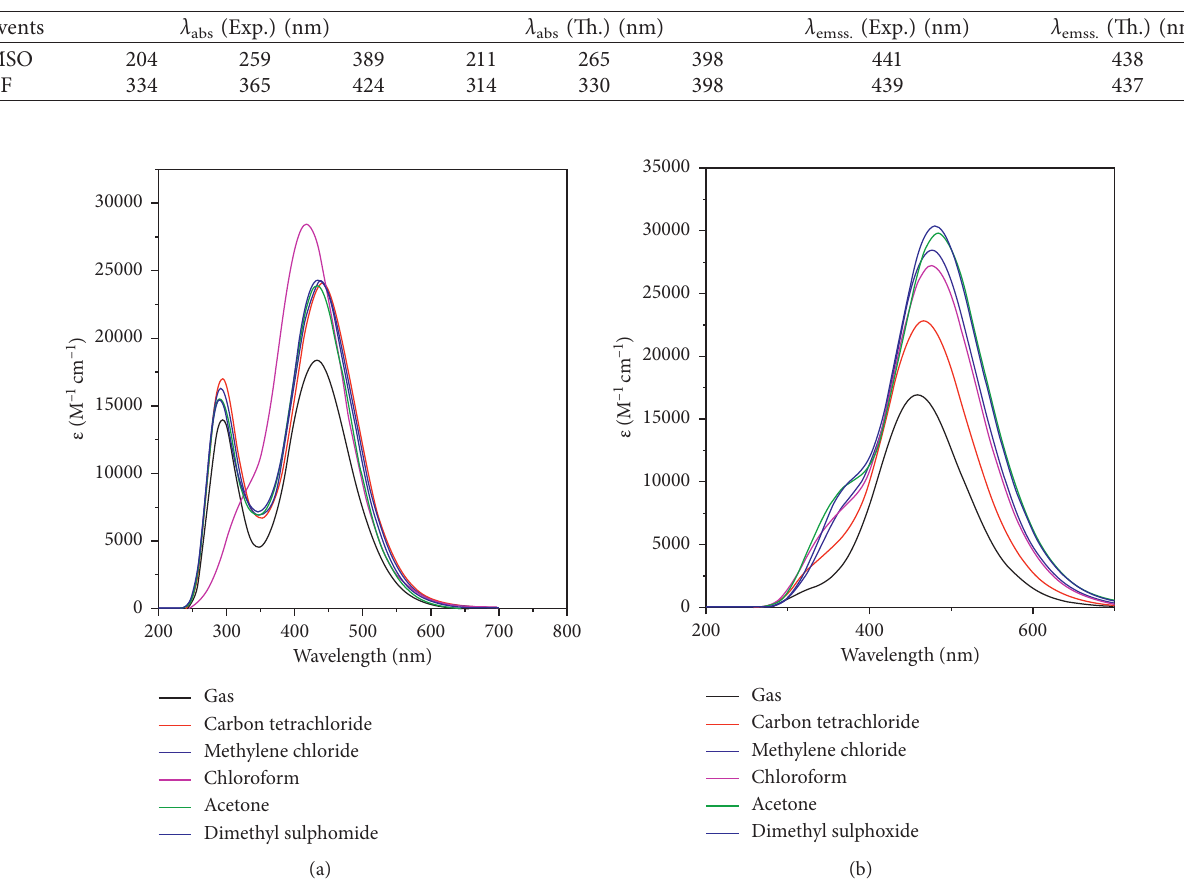
Figure 5: Calculated absorbance (a) and emission (b) spectra of the DDPA molecule in different solvents. The CAM-B3LYP/6-311G++ (d, p) level of theory was applied.